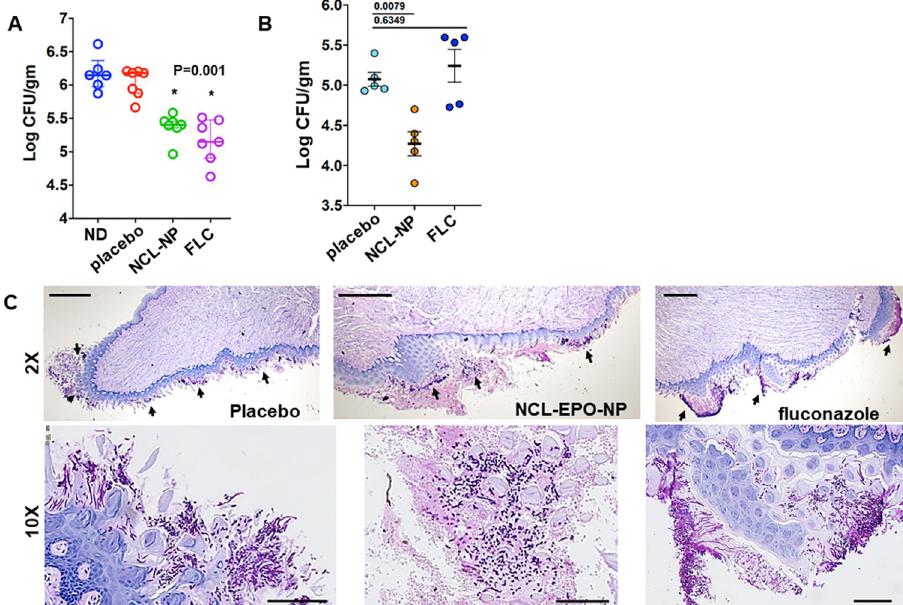
Fig 8. NCL-EPO-NP is efficacious against OPC. (A) Steroid-treated outbred CD1 mice were infected in their oral mucosa with C . albicans SC5314 and were treated intraorally with NCL-EPO-NP gels at 200 μ g per dose, twice/day for 4 days. The AU : PleasecheckandconfirmthattheeditstothesentenceThemicewerealsotreatedsimilarlywithgelswithoutNCL ::: arecorrect ; andamendifnecessary : mice were also treated similarly with gels without NCL as a placebo control and intraperitoneally with fluconazole on days 3 and 4. Mice killed AU : PleasenotethatasperPLOSstyle ; donotusesacrificeinreferencetokillingofanimalsduringexperiments : Hence ; allinstancesof } sacrificed } havebeenreplacedwith } killed } throughoutthetext : at day 5 postinfection (7 mice per arm) were monitored for fungal CFU in their tongue and presented as log CFU/gm of tissue. (B) Efficacy of NCL-EPO-NP in preventing OPC was also seen during infection by a fluconazole-resistant strain of C . albicans . (C) The tongues infected with a